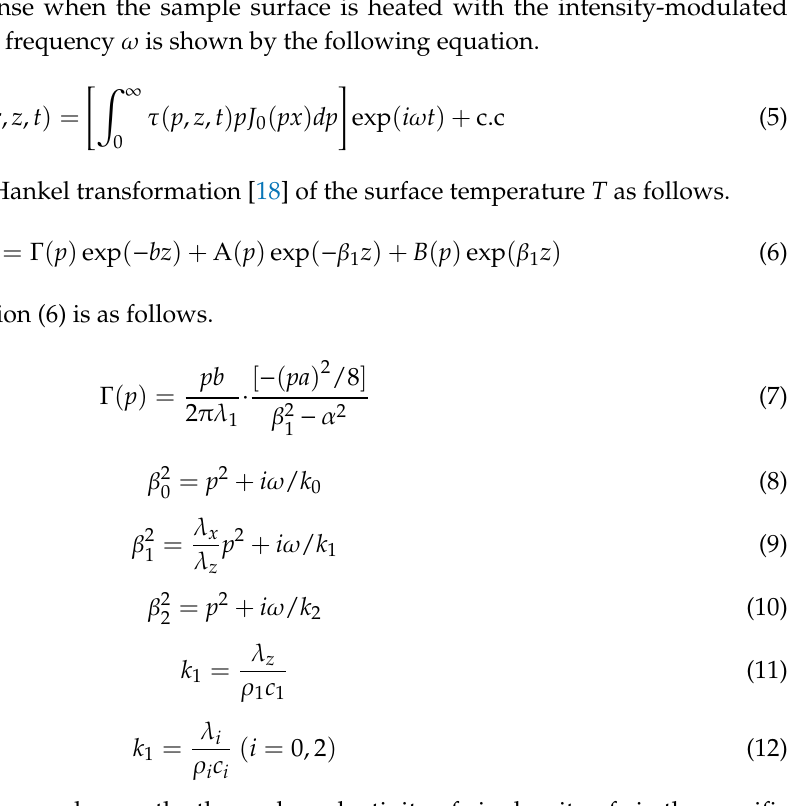
Figure 3. Schematic of the heating laser beam.